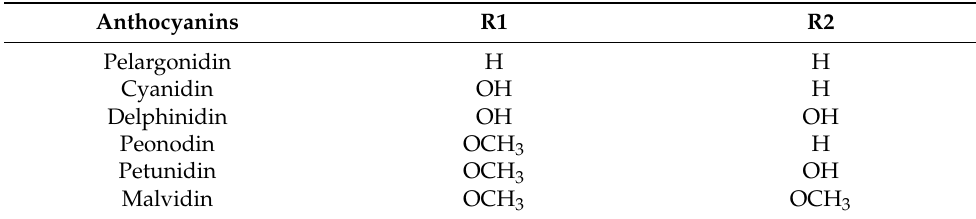
Table 1. R1 and R2 Substituents of Six Basic